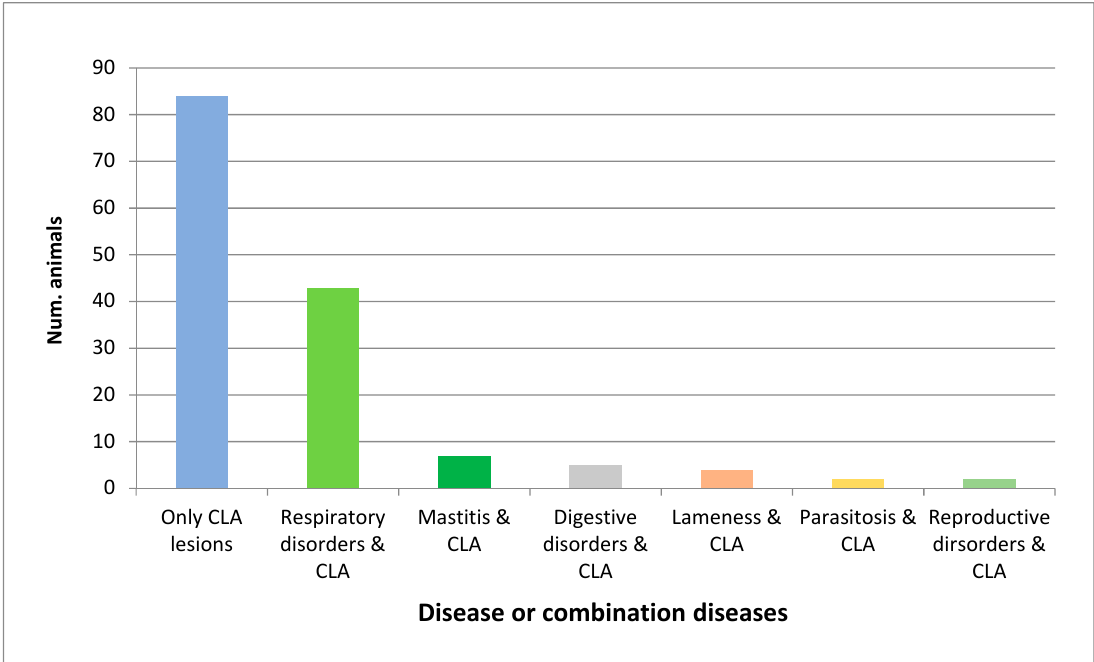
Figure 2. The number of culled sheep affected only by caseous lymphadenitis (CLA) or with concomitant diseases is shown. Respiratory disorders included ovine respiratory complex, pulmonary lentiviral infections, ovine pulmonary adenocarcinoma, gangrenous pneumonia and combinations of these diseases. Digestive disorders included Johne’s disease, mandibular osteomyelitis and other digestive disorders. Reproductive disorders were mainly metritis.